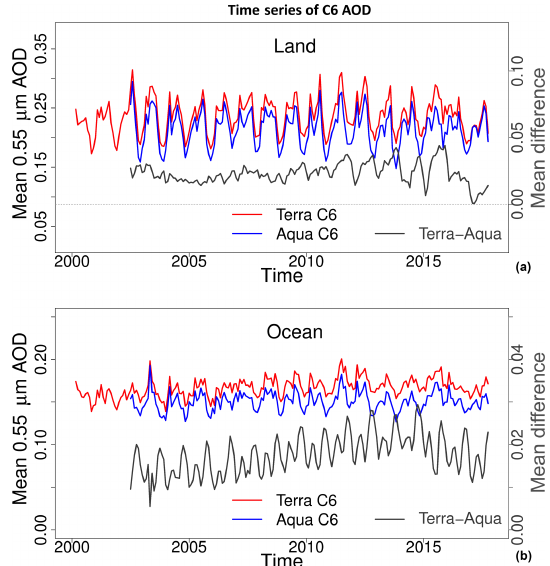
Figure 1. Time series of Collection 6, monthly global mean AOD (at 0.55µm) over land (a) and ocean (b) . For each panel, mean AOD (left axis) derived from MOD04 (Terra) is in red, from MYD04 (Aqua) it is in blue and the differences (right axis, MOD04- MYD04) are in